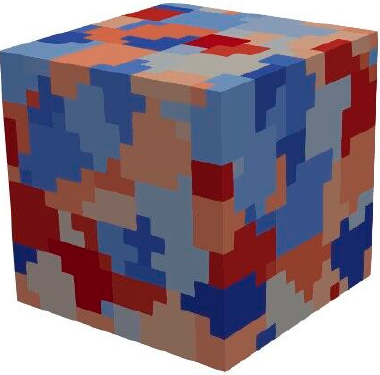
Figure 6. The representative volume element (RVE) used for simulation.